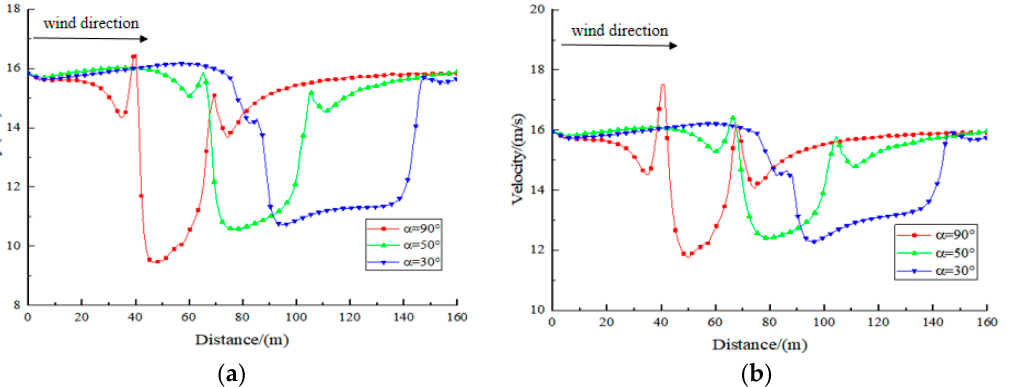
Figure 5. Wind-speed distribution at different heights from the top of the embankment. ( a ) Change of wind speed at 0.3 m from the top of the embankment. ( b ) Change of wind speed at 0.5 m from the top of the embankment